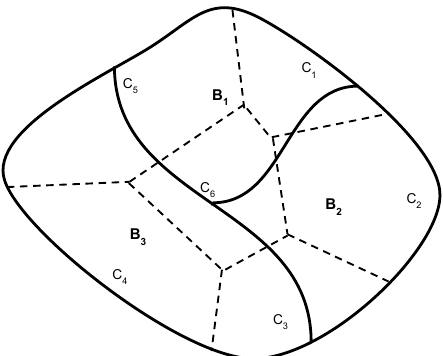
Figure 4. Example of overlay between voronoi and neighborhood administrative